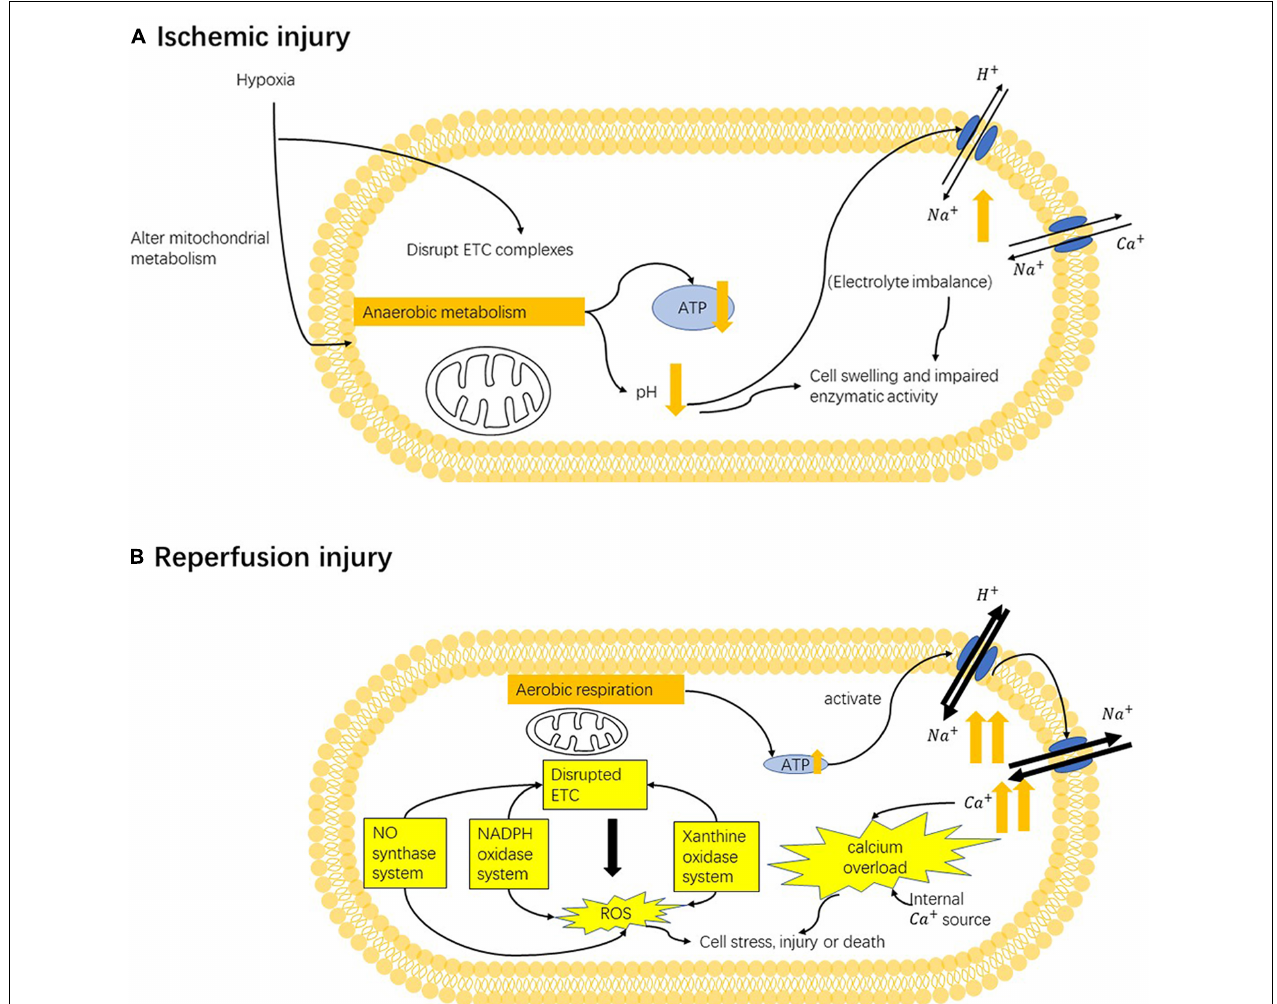
FIGURE 2 | Mechanism of ischemia-reperfusion injury. (A) In the ischemic state, hypoxia (oxygen deficiency) converts mitochondrial metabolism from aerobic to anaerobic, resulting in lower ATP generation. Anaerobic respiration also induces metabolic acidosis and leads to the activation ion-exchange channels. Altered electrolyte imbalance can cause cell swelling and impair enzymatic activity. Moreover, under hypoxia, the mitochondrial electron-transport chains (ETCs) are also disrupted. (B) In the reperfusion state, mitochondrial damage and cellular alternations caused by previous hypoxia can stimulate the production of reactive oxygen species (ROS) from multiple sources: the NADPH oxidase system, nitric oxide synthase system, xanthine oxidase system and mainly mitochondrial electron-transport chains. Such enhanced oxidative stress can target mitochondria ETC and cause further damage ETC, causing more ROS production. Oxidative stress can cause secondary cellular damage. Restoration of oxygen can induce the overactivation of pumps that are inhibited by ischemia-induced ATP deficiency, which rapidly triggers the influx of sodium ions and later calcium ions. Altering calcium homeostasis causes cellular damage, stimulates ROS production and induces cell death by triggering the opening of mPTP and activating apoptotic pathway.